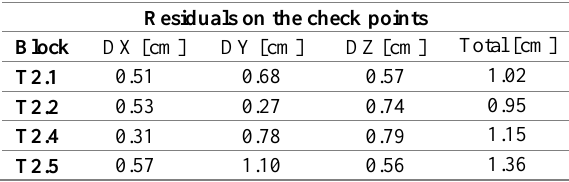
Figure 4. Colour map of distances between the photogrammetric models of T1.1 and T1.3 at the absolute maximum distance of 25 cm.